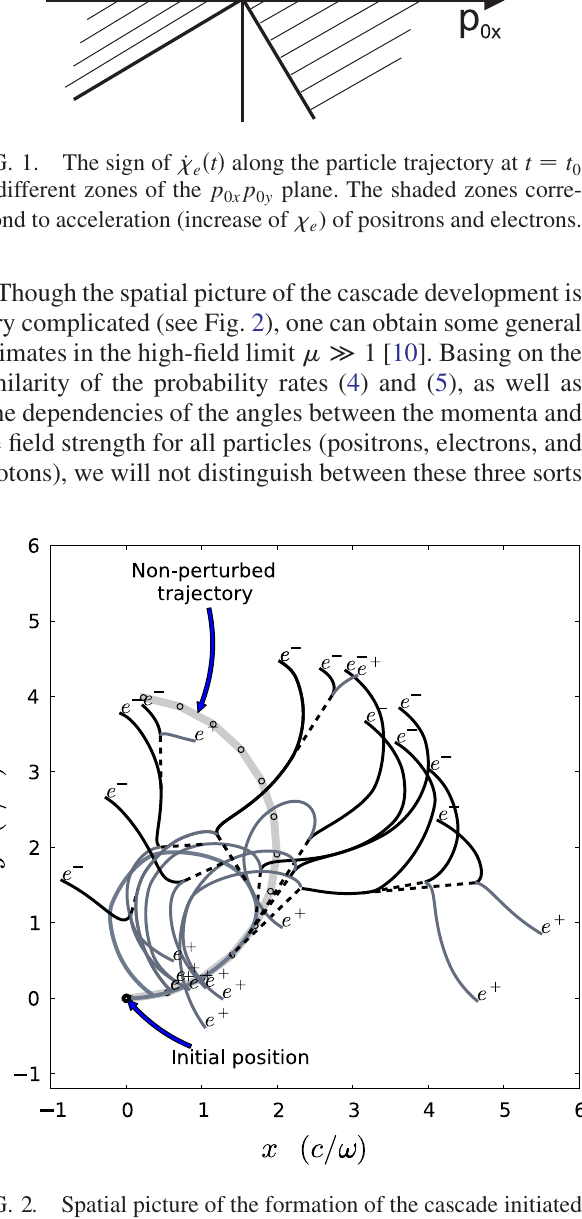
FIG. 2. Spatial picture of the formation of the cascade initiated by a positron in the homogeneous uniformly rotating electric field (obtained by a Monte-Carlo simulation with a 0 ¼ 2 (cid:1) 10 3 and @ ! ¼ 1 eV ). Legend: Trajectories of electrons and positrons are shown as black and gray curves, respectively. The hard photons which have created pairs during the simulation time are shown as the dashed lines. The trajectory of the primary positron ignoring any QED processes is plotted as the thick light gray